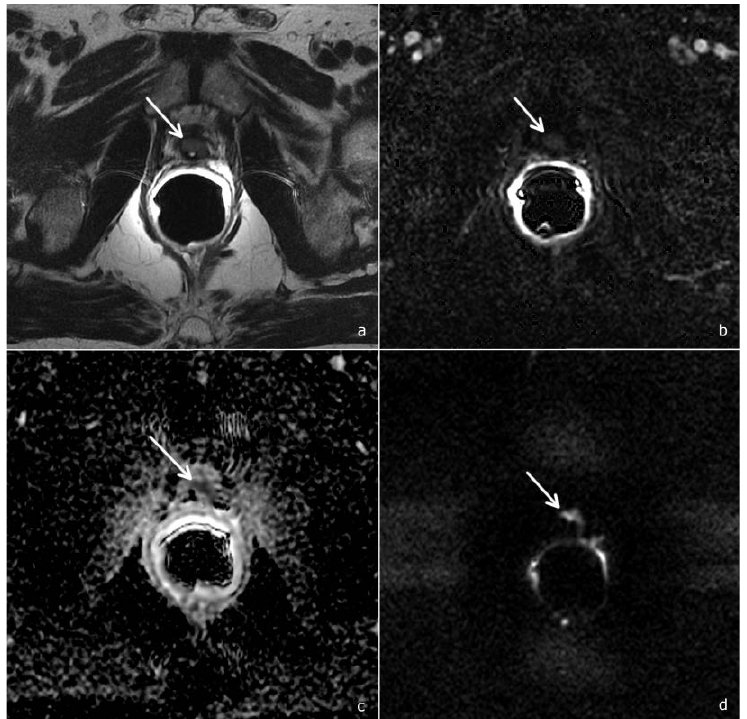
Figure 4. A PI-RR-score-4 (arrows), in a patient 72 years old, with a PSA value of 0.71 ng/mL. ( a ) T2-weighted image documents hypointense tissue localized anteriorly to the vesico-urethral anastomosis. ( b ) DCE depicts a focal mild and late enhancement. However, as the ADC map ( c ) and DWI ( d ) show a significant diffusion restriction (DWI score = 4), the overall PI-RR score was 4.